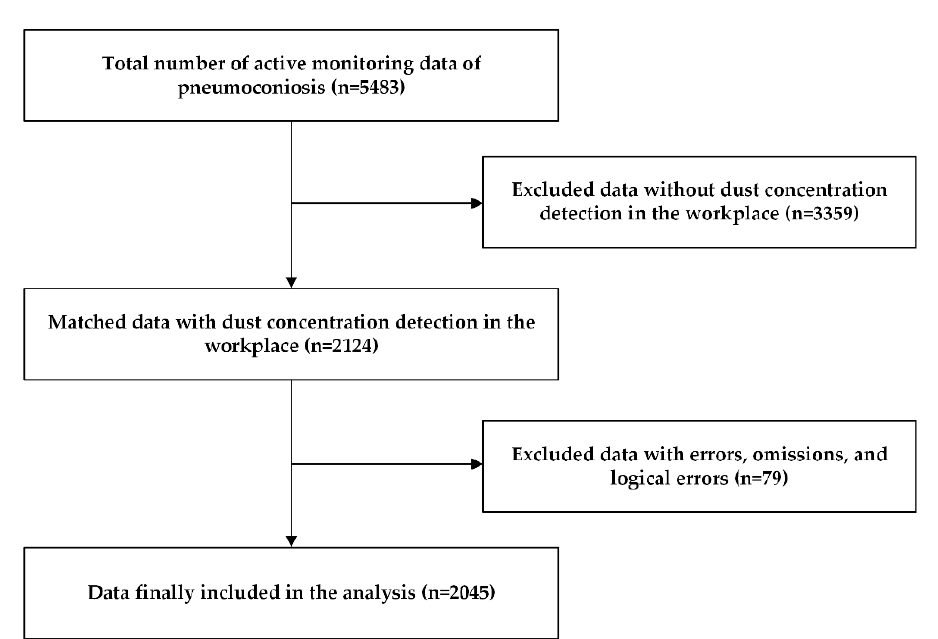
Figure 1. Flowchart of the enrolled study subjects.